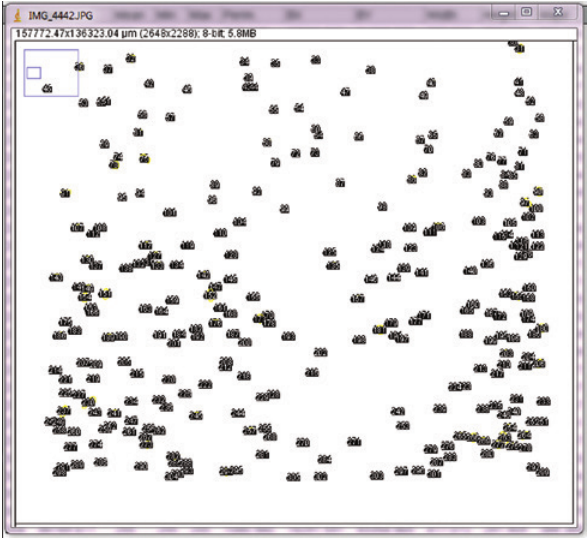
Figure 3: Image J software result window for droplet